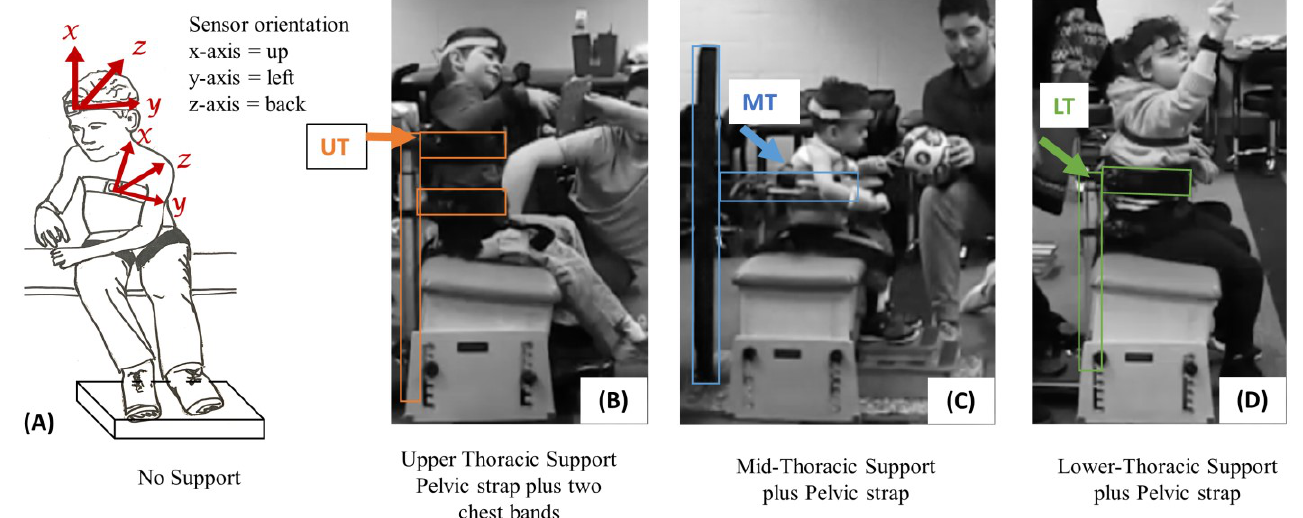
Figure 1. Sensor placement, orientation, and support conditions. Sensors were securely strapped to the children’s heads and chests. Pelvic support stability strapping was included for all levels of support ( A ), and external support was provided at upper (UT), mid (MT), or lower thoracic (LT) regions based on each child’s segmental level of trunk control. The black torso bands are connected to a vertical bar behind the child to provide support at the appropriate level. Trunk supports shown are ( B ) Meerkat with 2 torso bands at UT and LT, ( C ) Custom trunk support device with one band at MT, and ( D ) Meerkat with 1 band at LT.